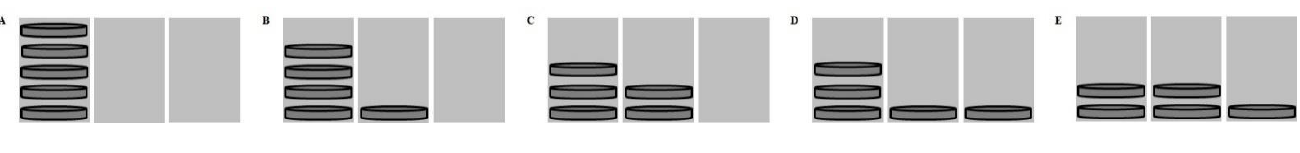
Figure 1. Example of a trial with the step-by-step optimal solution: ( A ) beginning state, ( B ) first move, ( C ) second move, and ( D ) third and final move.